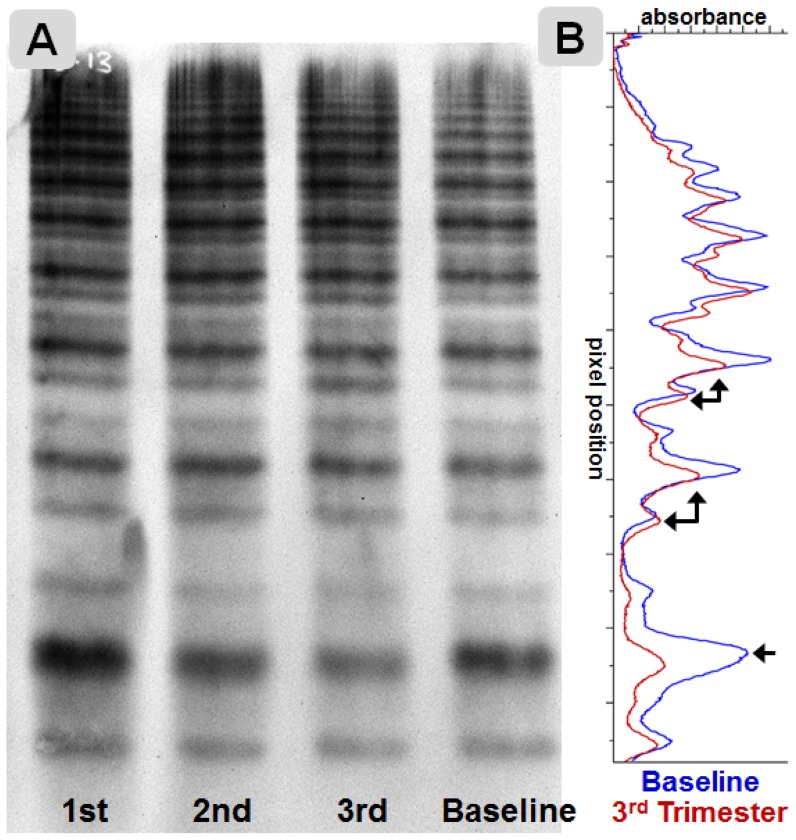
Change in VWF triplet structure in pregnancy.A normalized high resolution 2.6% multimer gel (A) and densitometry (B) of the same pregnancy shown in Fig 3 demonstrating the most commonly observed pattern of shifted VWF triplet structure with relative loss of height of the major band in the 3rd trimester (red) compared to baseline (blue).